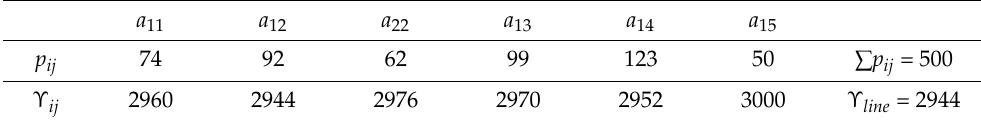
Table 3. Traditional ALB assignment.